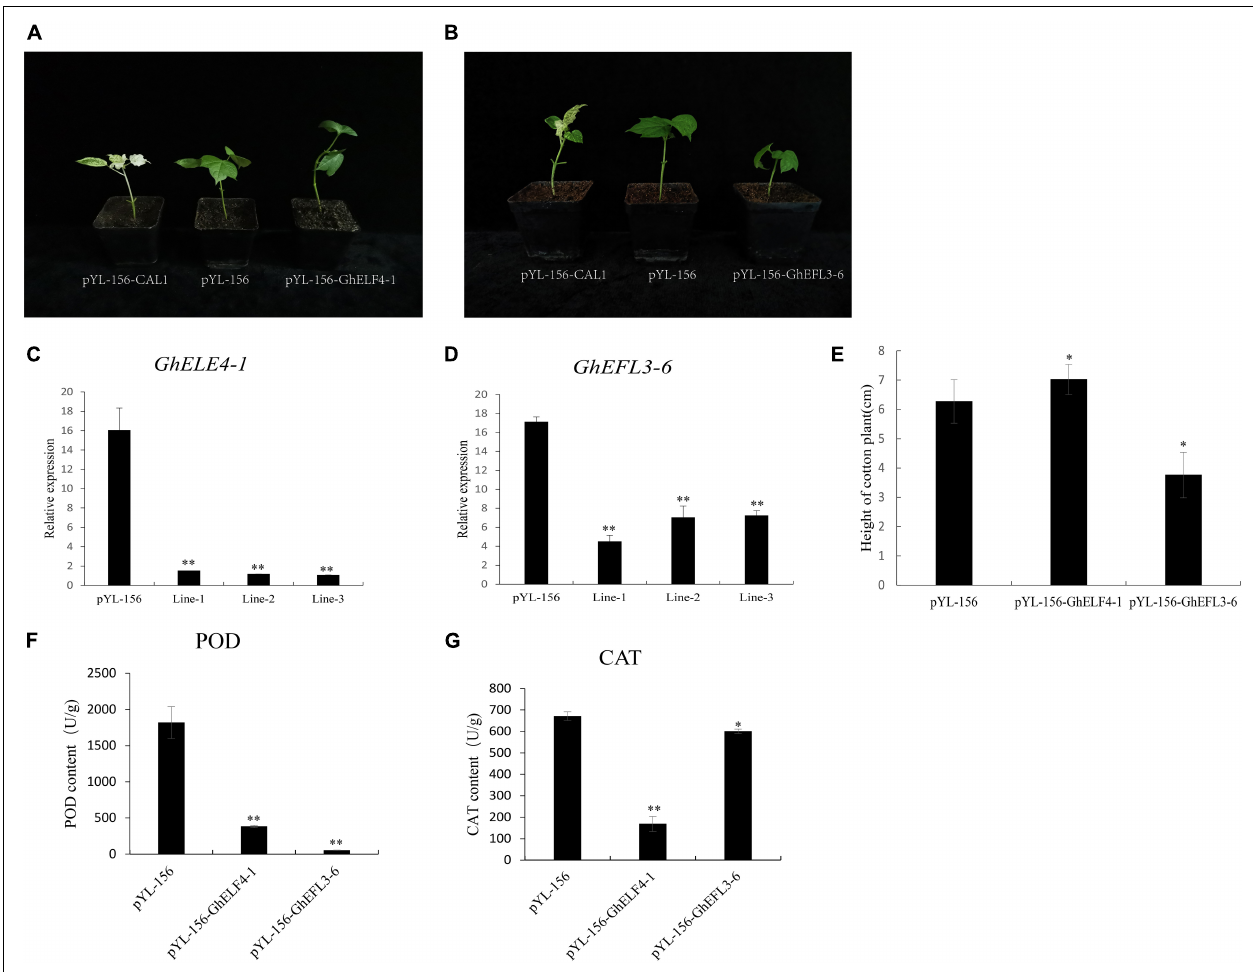
FIGURE 9 | Silencing of GhELF4-1 and GhEFL3-6 decreased resistance to salt stress in cotton. (A) Comparison of pYL156-GhELF4-1 plant phenotype and pYL-156-cal1, pYL-156; (B) Comparison of pYL156-GhEFL3-6 plant phenotype and pYL-156-cal1, pYL-156; (C) The relative expression levels of pYL-156 and pYL-156-GhELF4-1; (D) The relative expression levels of pYL-156 and pYL-156-GhEFL3-6; (E) Plant height statistics of pYL-156, pYL-156-GhELF4-1 and pYL-156-GhEFL3-6; (F) VIGS plant Peroxidase (POD) activity assay; (G) VIGS plant catalase (Silva et al., 2020) activity assay; ** P < 0.01, * P <